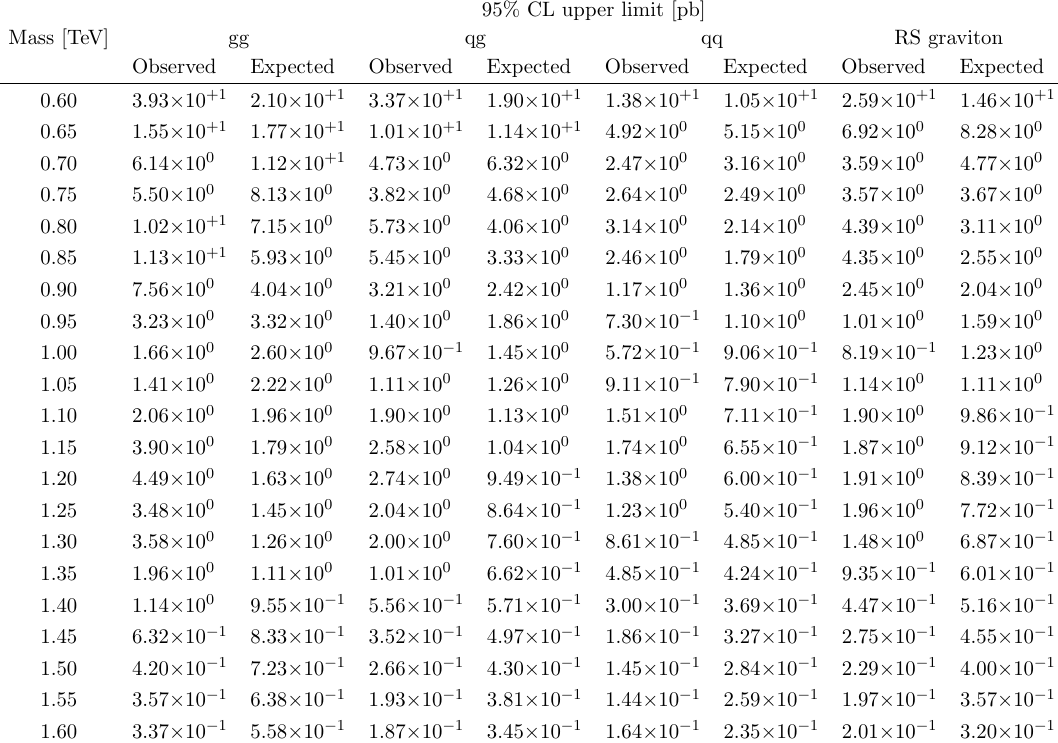
Table 1 . Limits from the low-mass search. The observed and expected upper limits at 95% CL on (cid:27)BA for gluon-gluon, quark-gluon, and quark-quark resonances, and an RS graviton are given as a function of the resonance